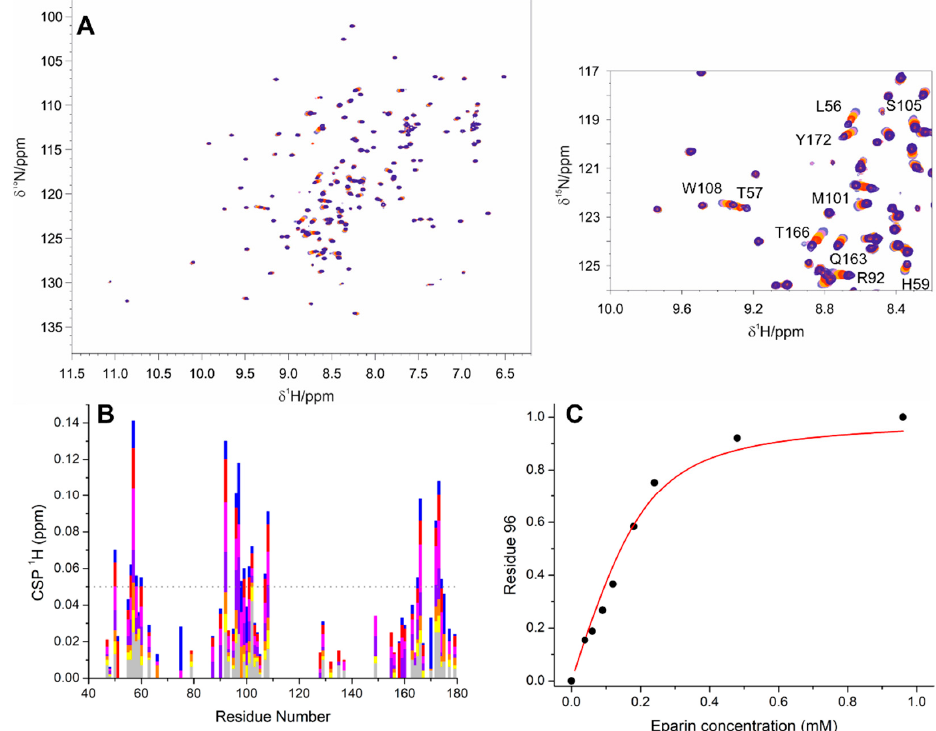
Figure 2. Panel ( A ) reports the overlay of NTD 2D HN spectra upon the addition of EP. Light blue, pink, orange, red, and blue represent the 1:0, 1:0.3, 1:0.6, 1:1.2, and 1:2.40 molar ratios of NTD:EP, respectively (the protein concentration was 200 µM). A zoom in a spectral region where several peaks are perturbed is reported on the right. The assignment of the most perturbed peaks is shown. Panel ( B ) reports the variations in chemical shifts of 1 H nuclei (CSP) against the residue number at 1:0.30, 1:0.45, 1:0.60, 1:0.90, 1:1.20, 1:2.40, and 1:4.80 of the NTD:EP ratios (grey, yellow, orange, violet, magenta red, and blue, respectively). Panel ( C ) reports the fittings and the obtained K d values for G96.